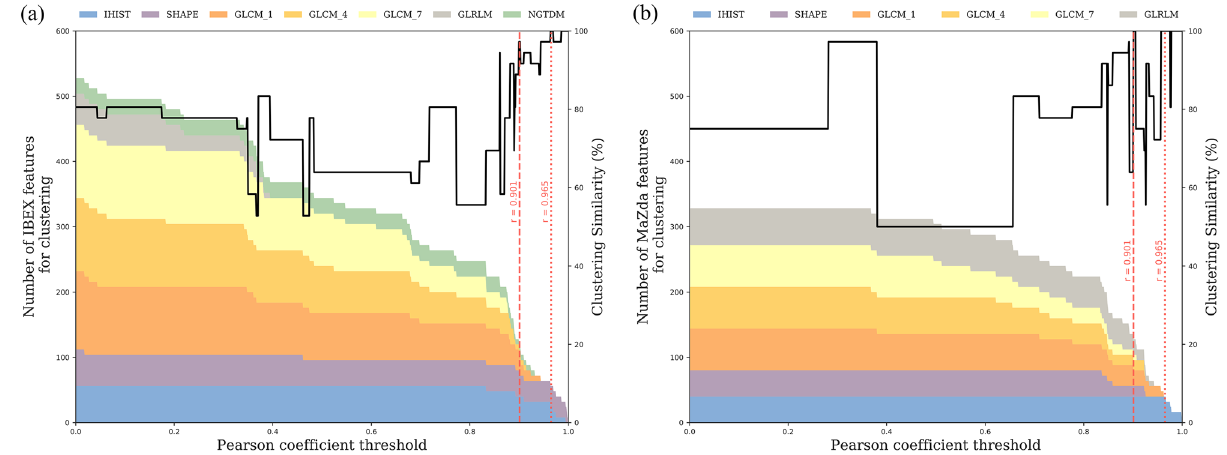
Figure 5. Impact of the reproducibility threshold on the number of ( a ) IBEX and ( b ) MaZda radiomics features used for clustering and the resulting clustering similarity. The number and composition of feature types is shown with the coloured area chart and shows a decrease in the number of features as the reproducibility threshold increases. The (black line) clustering similarity is relatively unchanged for a threshold up till 0.85 after which there is a general increase in accuracy for IBEX features. Two reliability thresholds are highlighted where (red dashed line) generates patient groups in IBEX with one patient classified differently and identical patient groups in MaZda and the (red dotted line) generates identical patient groups in both